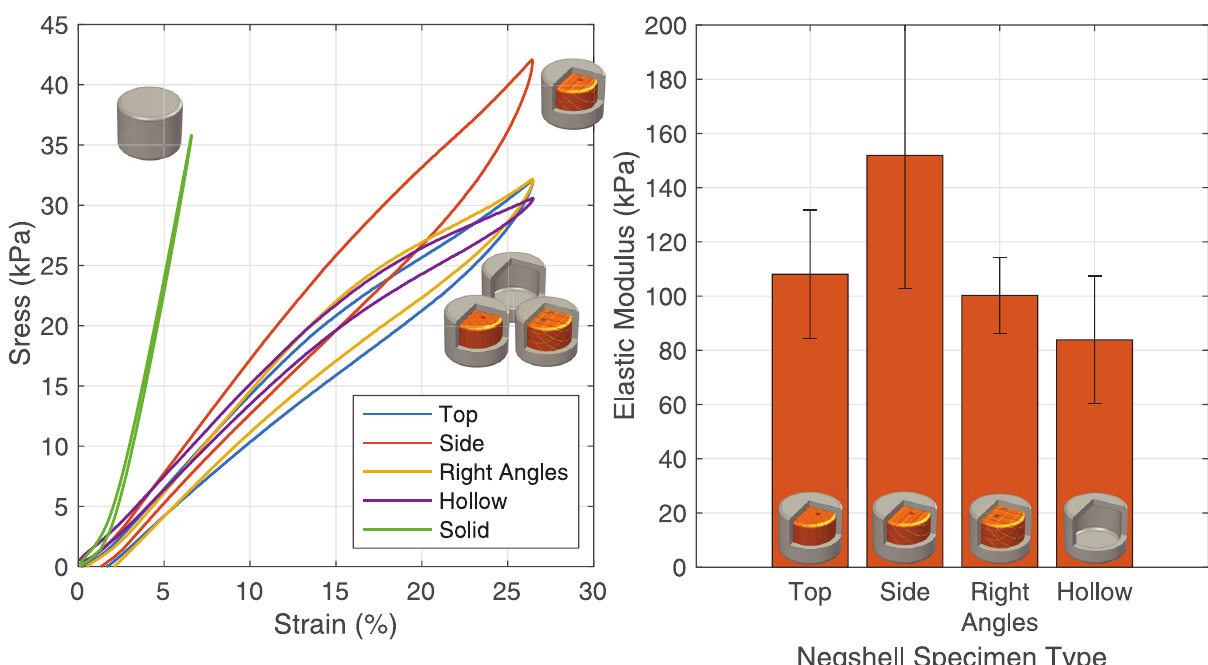
Fig 11. Negshell cores results. (Left) The stress-strain curve of the tested specimens show that the negshell cores minially effect the mechanical property of the specimens under compression. The stress-strain curve of a solid, homogeneous specimen is also plotted as refrence. (Right) The elastic modulus of the tested